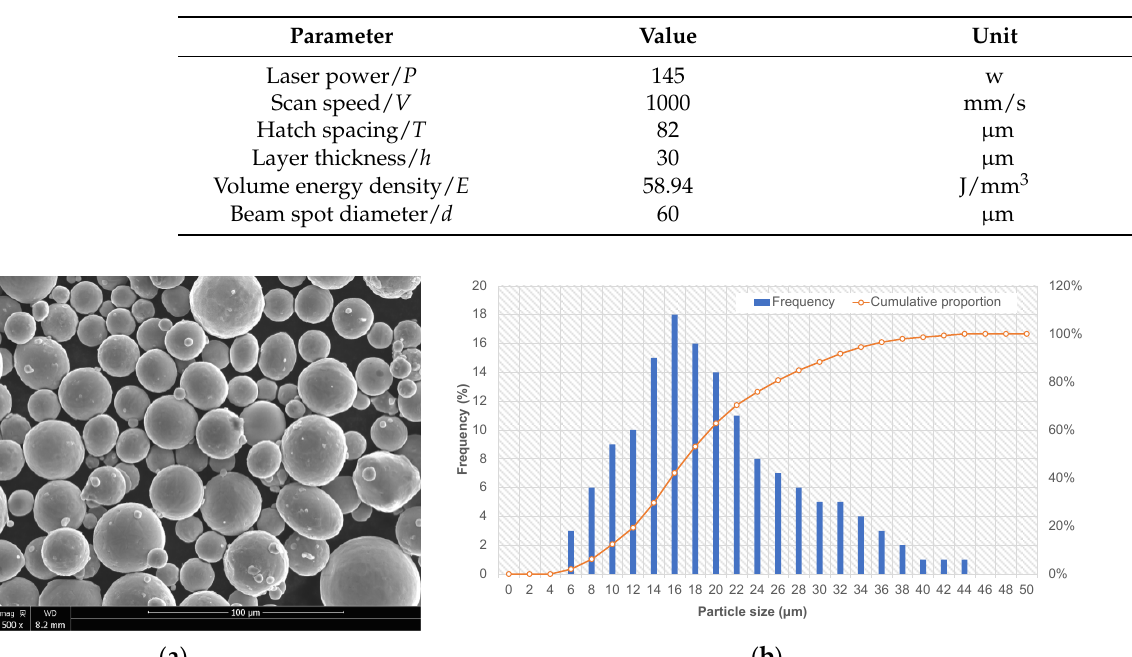
Figure 2. The powder information. ( a ) The microscopic morphology; ( b ) particle size distribution diagram of the Ti6Al4V powder used in the SLM process. Table 1. Chemical components of Ti6Al4V powder used in the SLM process.